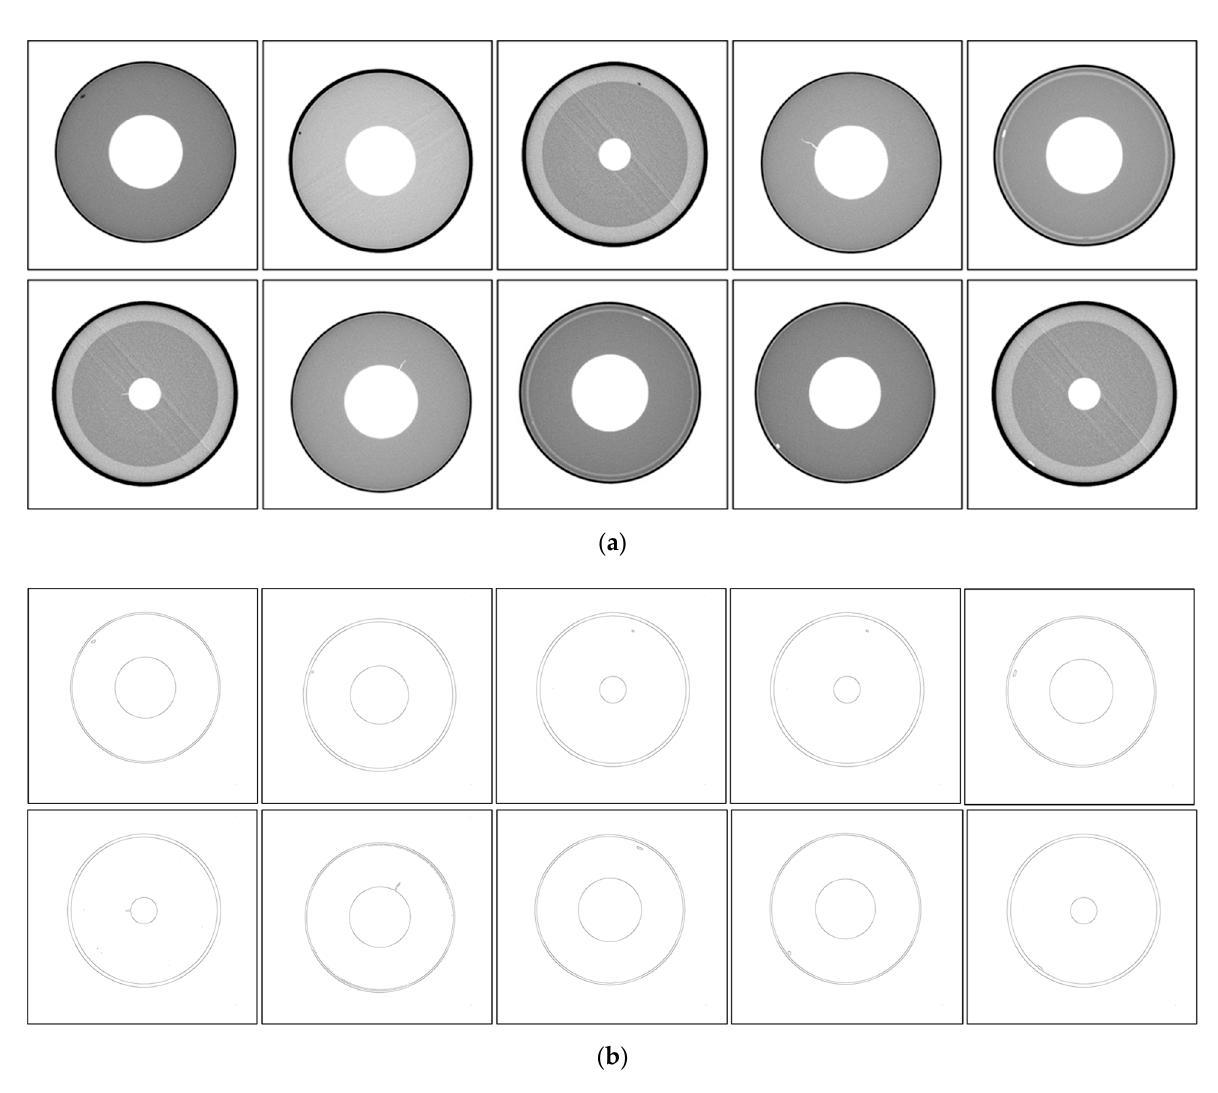
Figure 8. Randomly selected images: ( a ) the original images; ( b ) the corresponding Edge III effects. Table 3. The PSNR values of each type edge for randomly selected images.